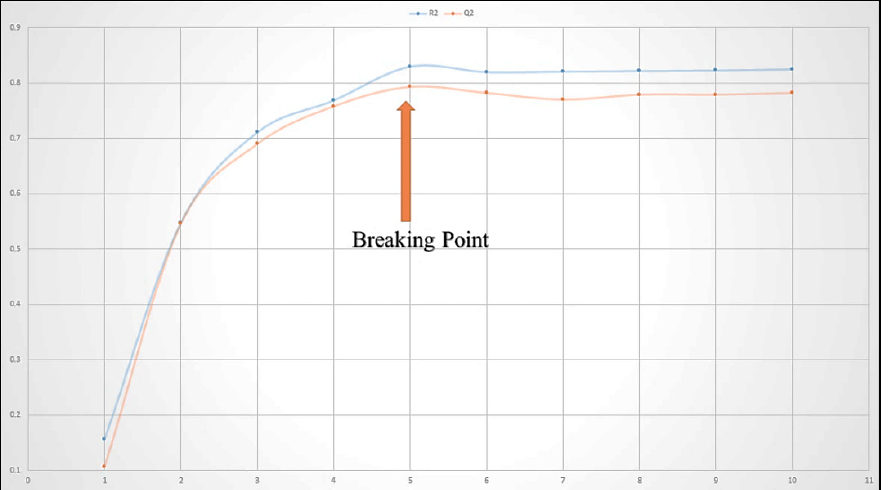
Figure 26. Depiction of Plot for the number of descriptors against the Coefficient of Determination R 2 and Leave-One-Out Coefficient of Determination Q 2 to identify the optimum number of de-